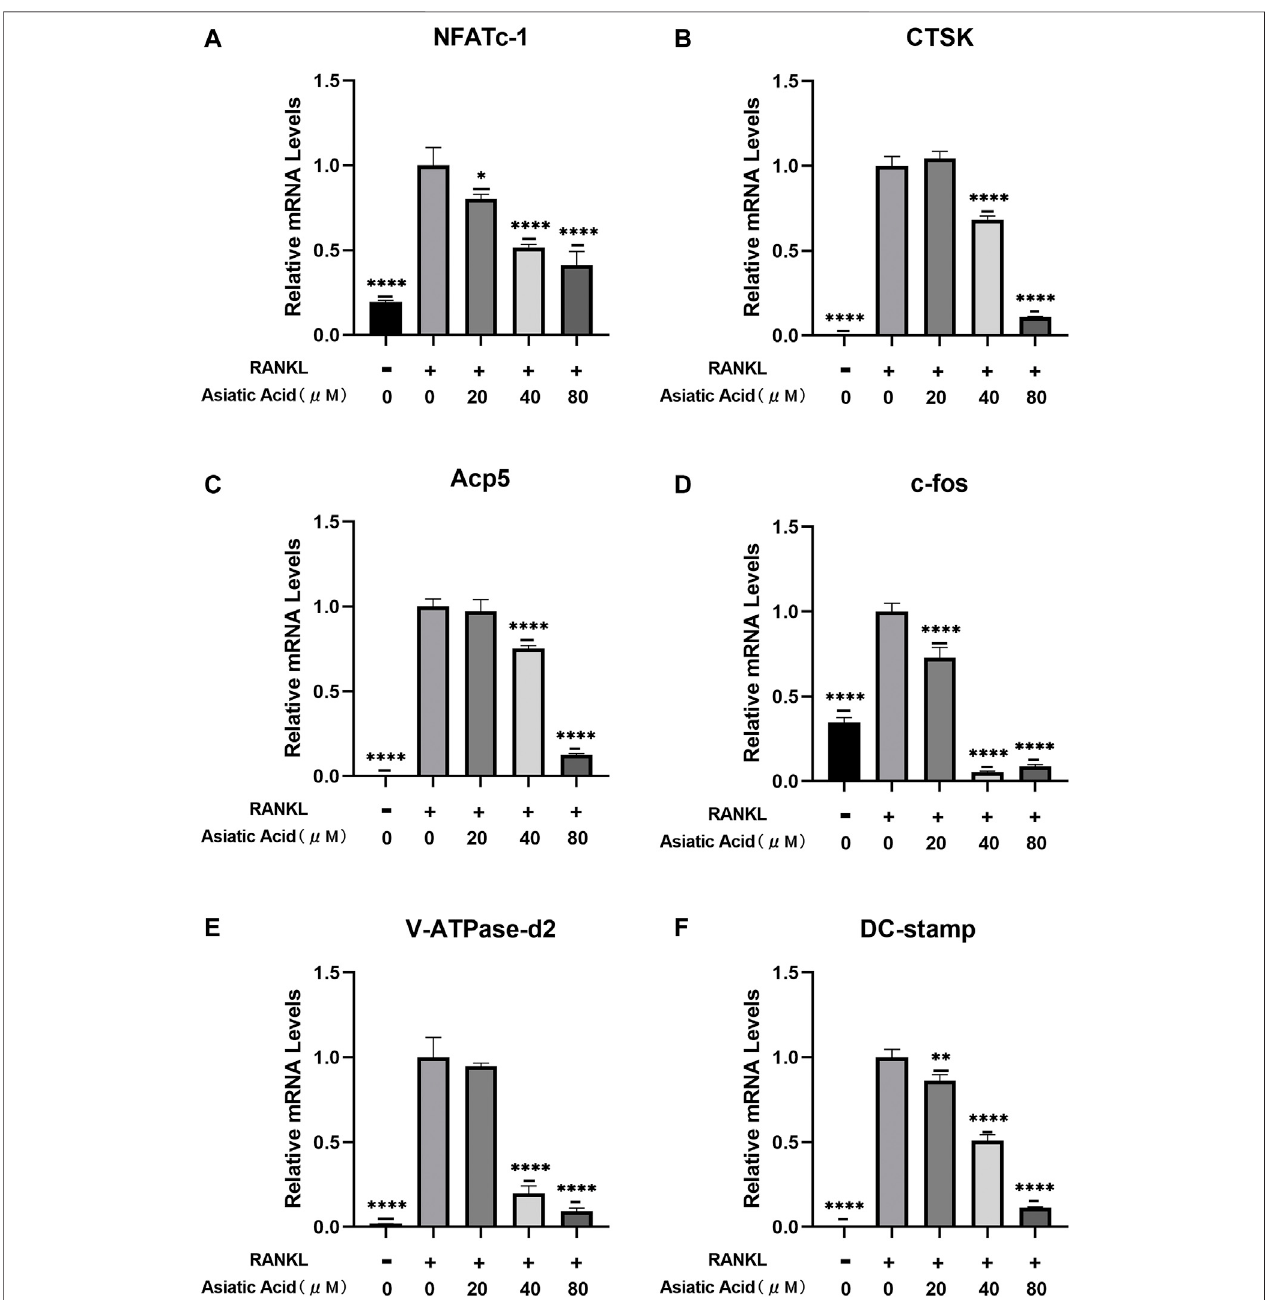
FIGURE2| Asiaticacid inhibitsRANKL-induced osteoclast-related geneexpression. (A – F) BMMs wereexposedtoM-CSF and RANKL for7 days withorwithout AA. The expression of osteoclast-speci fi c genes (e.g., NFATc1, c-fos, CTSK, Acp5, DC-stamp, and V-ATpase-D2) were detected with fl uorescence quantitative RT- PCR. All values are presented as the mean ± SD ( n = 3). * p < .05; ** p < .01; *** p < .001; **** p < .0001.